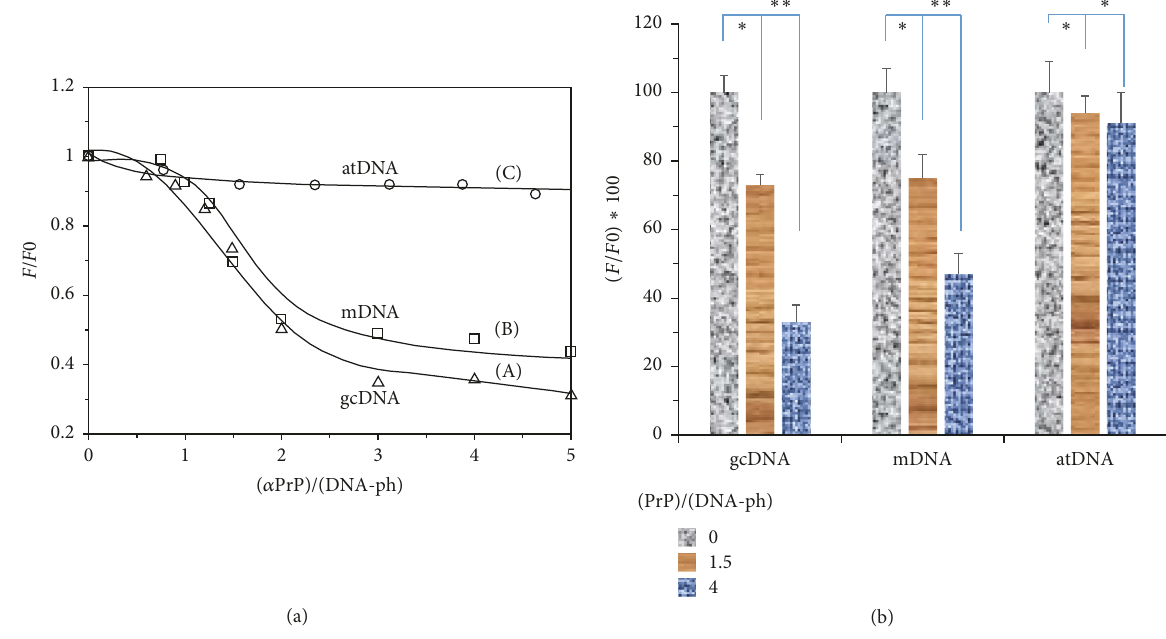
Figure 4: The effect of increasing concentrations of 𝛼 -PrP on the quenching of YOYO fluorescence bound to different DNAs in 20mM Hepes buffer, pH 7.4 containing 100 mM NaCl. (a) 𝐹 0 and 𝐹 are the fluorescence intensities of the dye in the presence of DNA before and after the addition of protein, respectively. DNA and dye concentrations in the experiments were 400 nM phosphate and 8nM dye. (A), gcDNA, (B), mDNA, and (C), atDNA. Excitation 485 nm; emission 505 nm. (b) A quantitative analysis was also performed to determine the relative quenching of YOYO as a measurement of DNA condensation by PrP. The statistical values were also calculated. ∗∗ represents 𝑝 < 0.01 , and ∗ represents 𝑝 < 0.05 . Temperature 20 ∘ C.